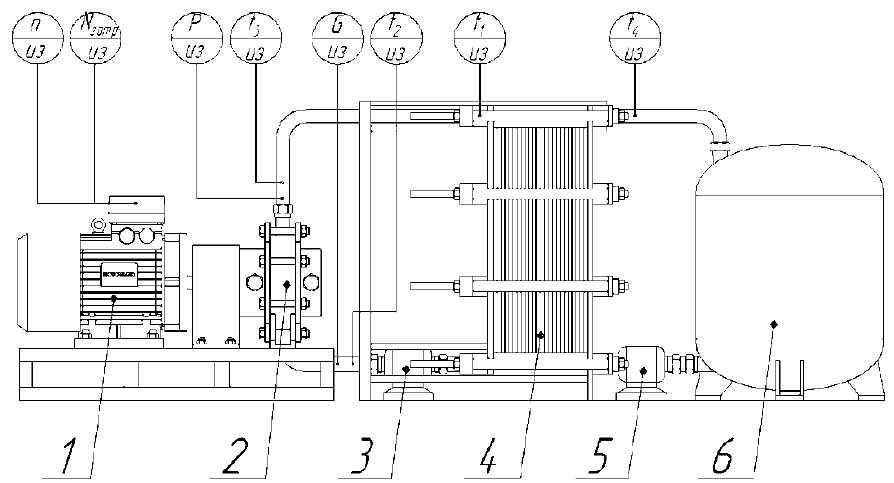
Figure 4. Experimental setup for testing the e ffi ciency of the disk pulse heat generator: 1–electric engine N = 15 kW · h; rotor speed n = 3000 rpm; 2–chamber of the disk pulse heat generator; 3, 5–centrifugal pump; 4–plate heat exchanger Alfa Laval; 6–storage